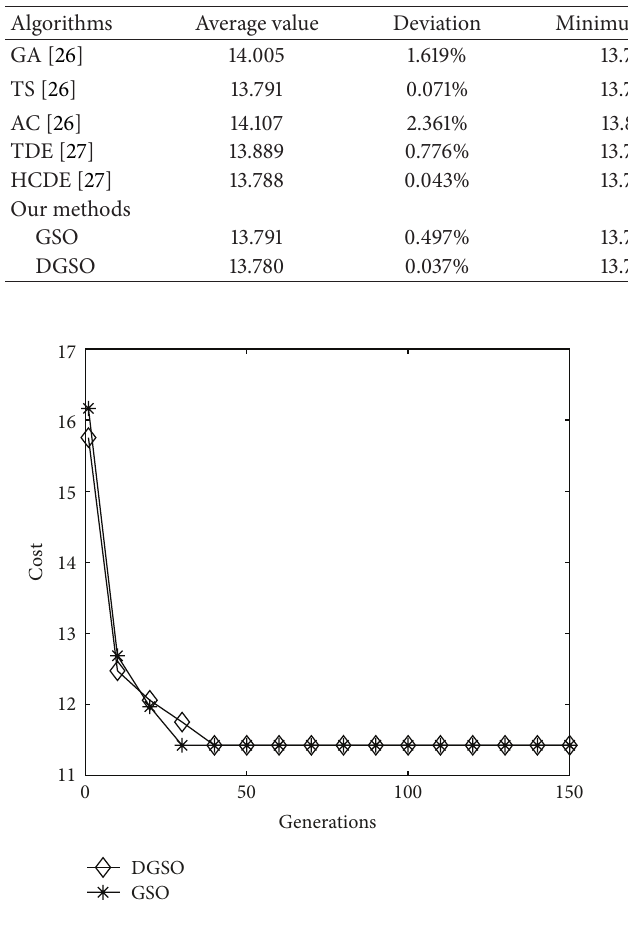
Figure 5: Performance index in successive generations ( 6 × 6